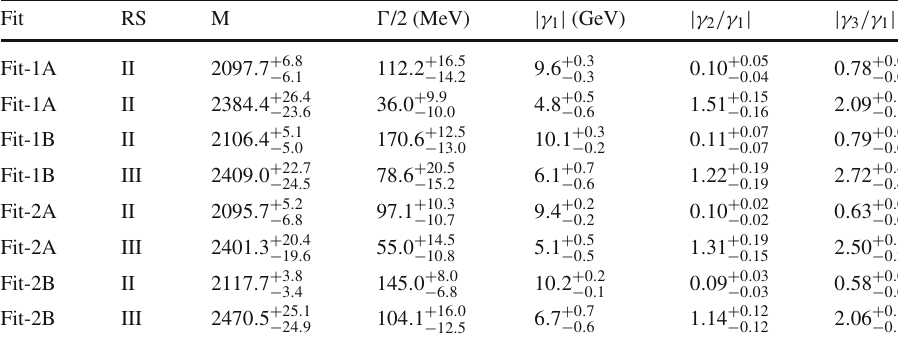
uncertainties. For Fit-2A and Fit-2B, all the parameter configurations within one-sigma uncertainties give bound state poles. The indices of the residues γ i = 1 , 2 correspond to the channels DK and D s η in order. The physical thresholds of the DK and D s η channels are 2362 . 8 and 2516 . 2 MeV, respectively. For the definition of the different RS’s,